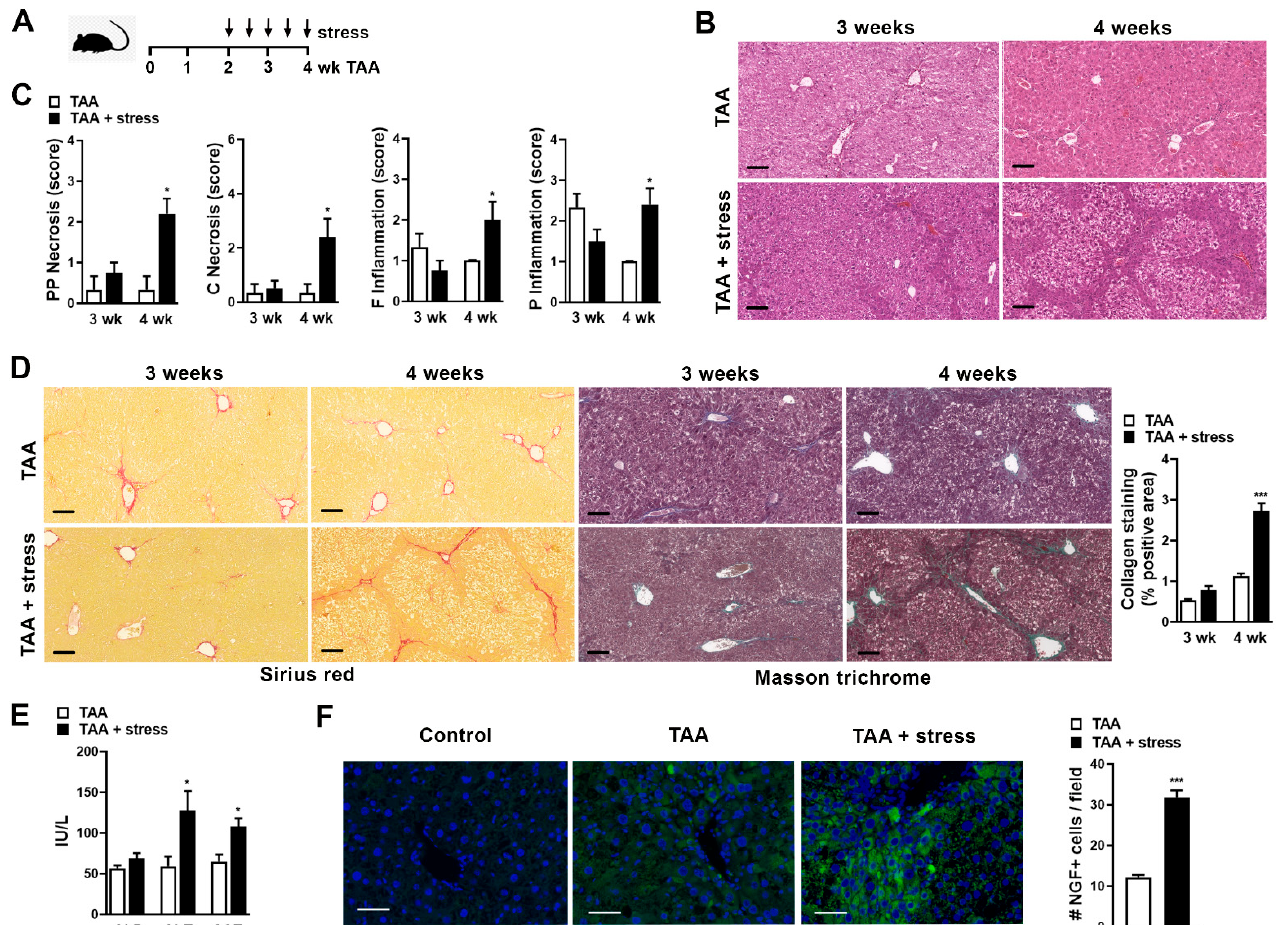
Figure 1. ( A ) Experimental murine model: Thioacetamide (TAA) was administered for 3 or 4 weeks (wk) to induce fibrosis and stress stimulus was performed by exposition to sound stress for the duration of 24 h starting on week 2 of TAA administration, twice a week. ( B ) Representative images of H&E staining at 3 and 4 weeks with fibrosis (TAA) or fibrosis with stress (TAA + stress). Bar = 100 µm. ( C ) Score of periportal and periseptal (PP) necrosis, confluent (C) necrosis, focal (F) inflammation, and portal (P) inflammation in livers at 3 or 4 weeks (wk) of fibrosis (TAA) or fibrosis with stress (TAA + stress). Results are expressed as mean score ± S.E.M. * p < 0.05 vs. TAA (Kruskal–Wallis test). ( D ) Representative images of Sirius red and Masson’s trichrome staining on liver sections. Bar = 100 µm. Quantification of collagen deposits based on Sirius red-stained sections was performed by morphometric analysis and % positive area ± S.E.M was depicted. *** p < 0.001 vs. TAA (Kruskal–Wallis test). ( E ) Alkaline phosphatase (ALP), aspartate transaminase (AST), and alanine aminotransferase (ALT) were measured in serum. * p < 0.05 vs. TAA (Mann–Whitney test). ( F ) Representative images and NGF expression in liver as number of NGF + cells/field ± S.E.M is shown. Negative immunofluorescence control without NGF antibody is also shown (control). Bar = 50 µm. *** p < 0.001 vs. TAA (Mann–Whitney test).